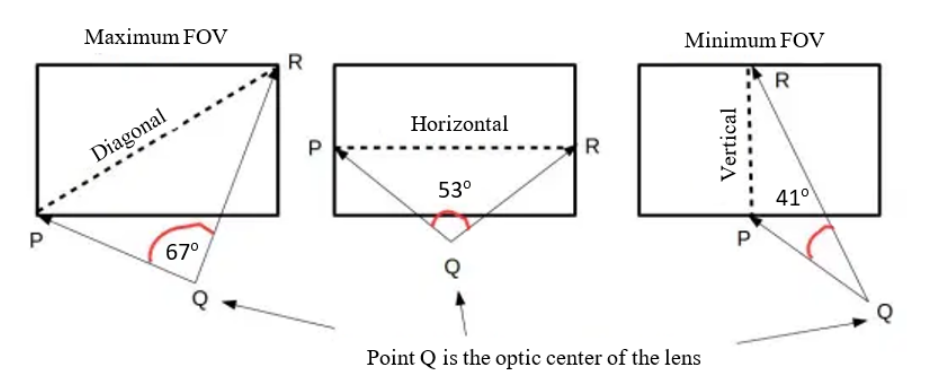
Figure 5. Field of view comparison.